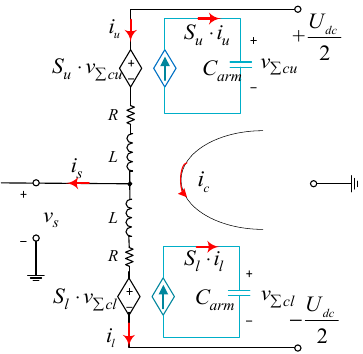
Figure 4. The average equivalent circuit of one phase of MMC.